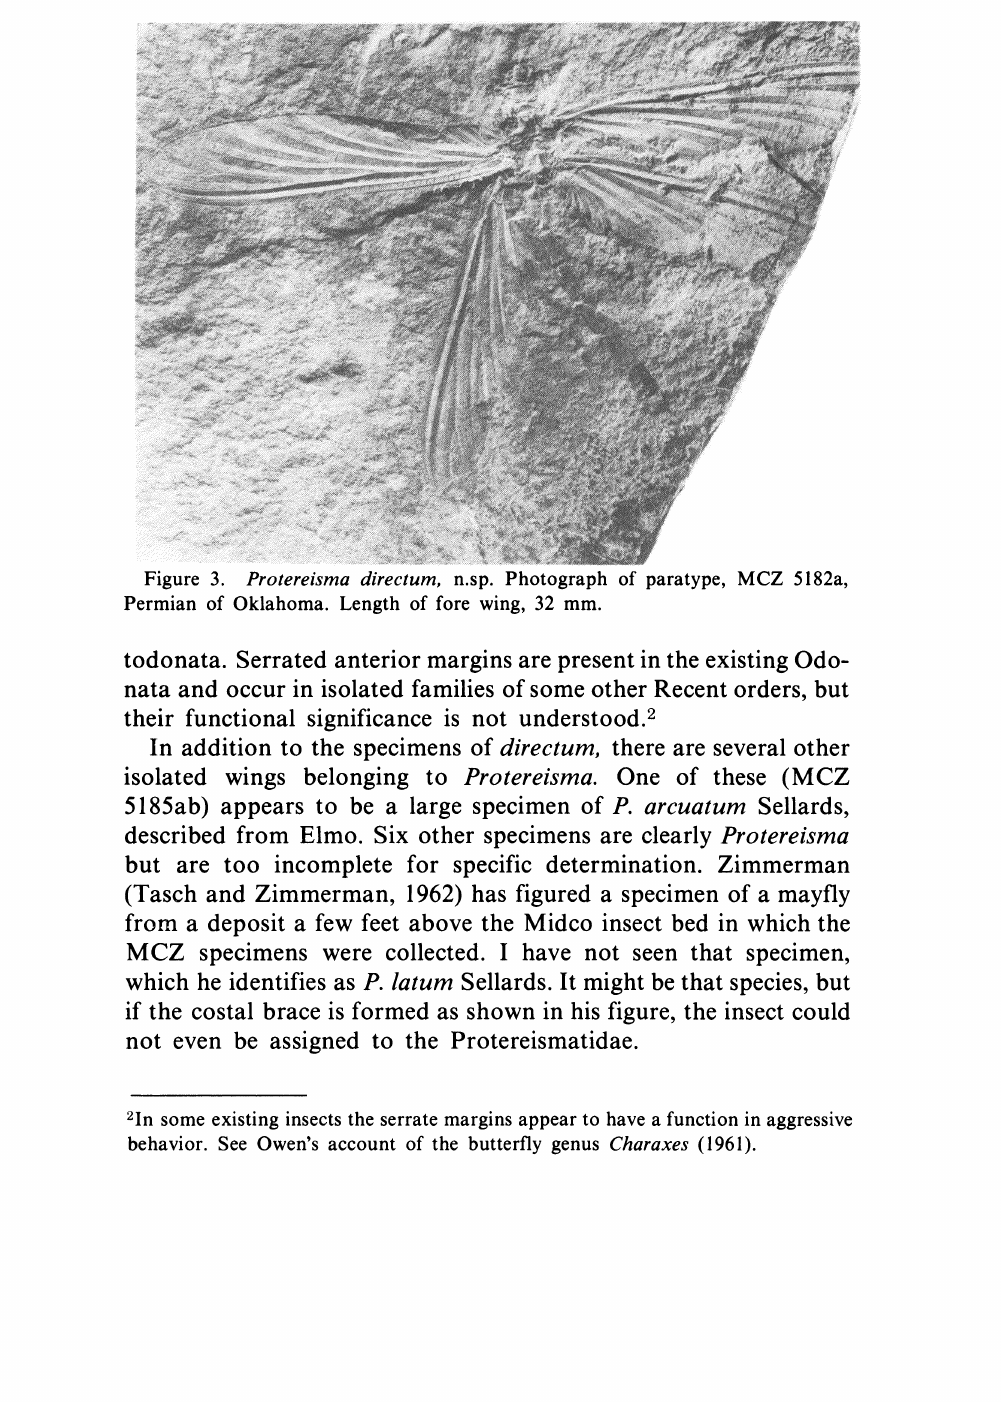
Figure 3. Protereisma directum, n.sp. Photograph of paratype, MCZ 5182a, Permian of Oklahoma. Length of fore wing, 32 mm. todonata. Serrated anterior margins are present in the existing Odo- nata and occur in isolated families of some other Recent orders, but their functional significance is not understood.